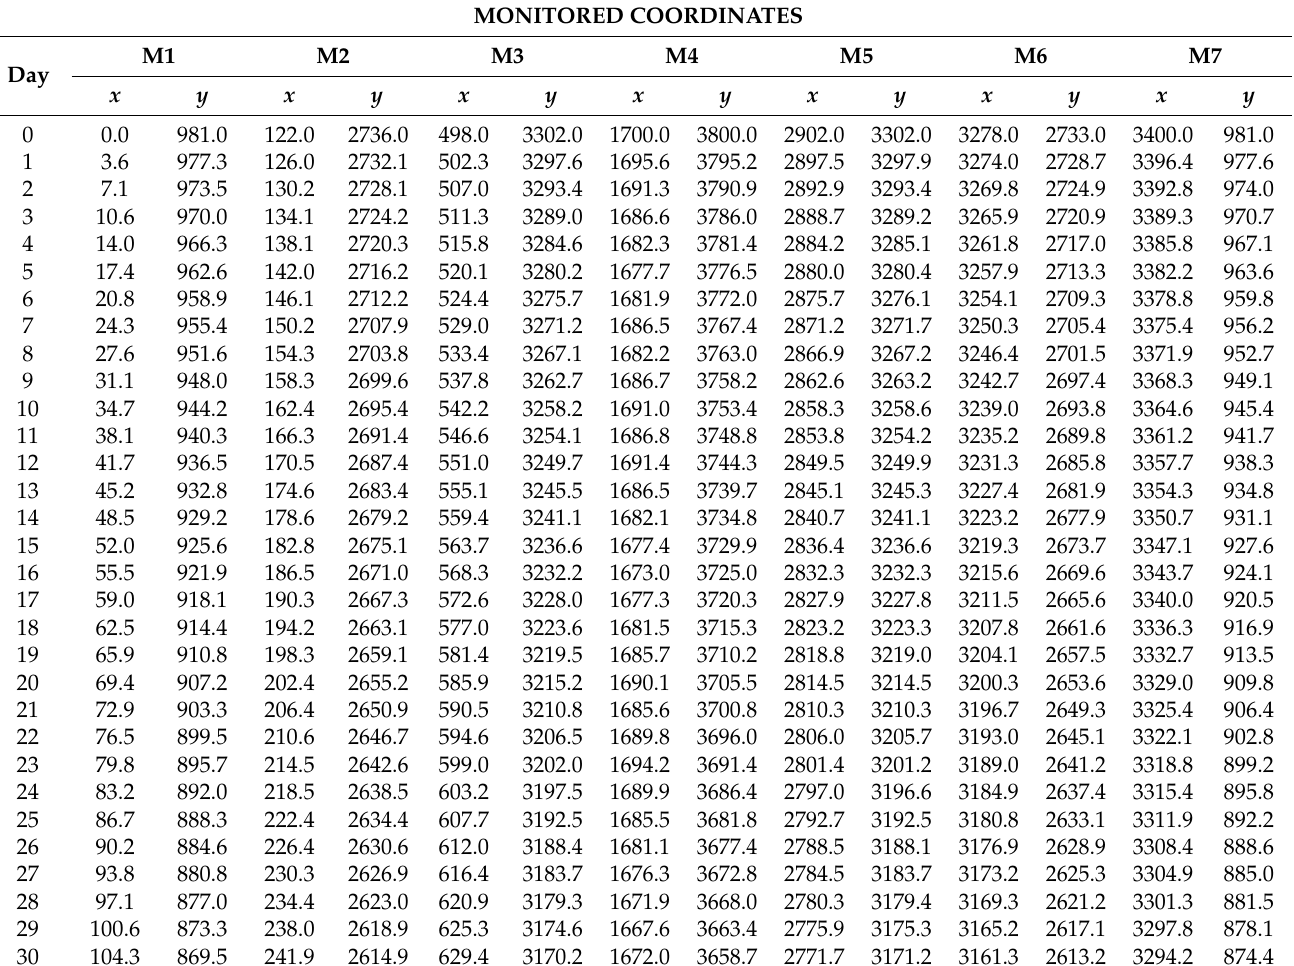
Table 6. Monitored coordinates of markers.